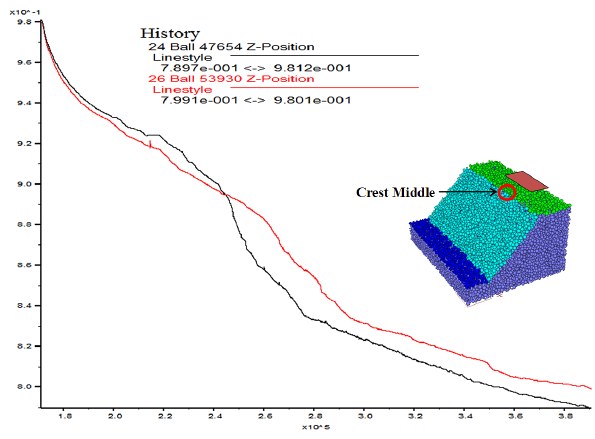
Figure 13. Vertical position history for the balls at the crest middle.